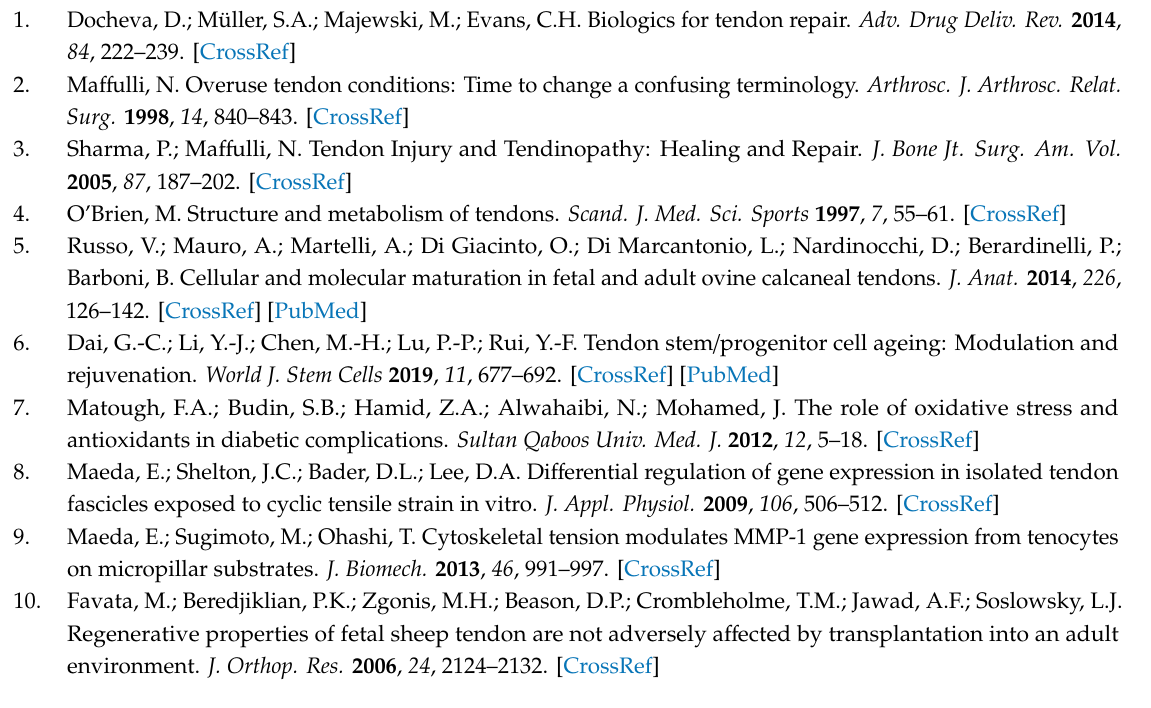
title: “Sca ff old innovation for the cure of tendon disorders: development of a new generation of poly-hyaluronate functionalized biocomposites”. Maria Rita Citeroni, grant number C41I17000200006, project title: “Tendon regenerative medicine: amniotic stem cells and their secretome for the development of hyaluronate functionalized sca ff olds”. Mohammad El Khatib, grant number C42F16000350001, project title: “Tendinopathies and